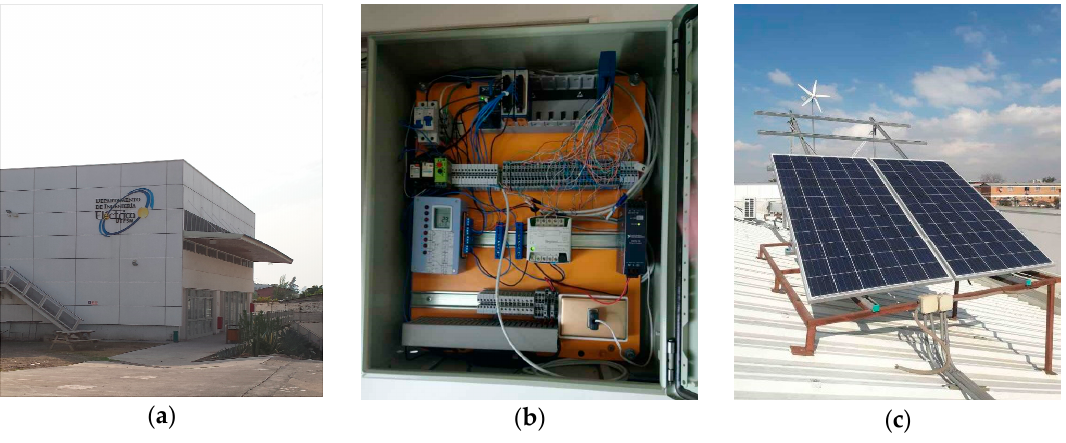
Figure 1. Facilities. ( a ) Building; ( b ) Sensor connections; ( c ) Solar panels.